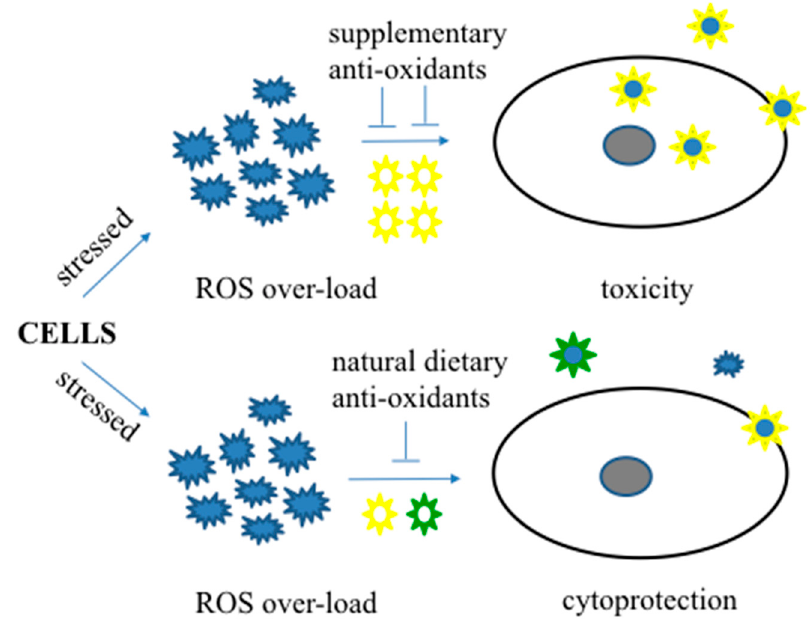
Figure 2. A schematic showing the beneficial roles of dietary anti-oxidants (moderate amounts of multiple anti-oxidants) and harmful roles of anti-oxidant supplements (higher amounts of individual anti-oxidant) during stressed conditions.